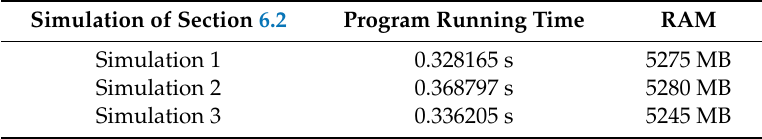
Table 11. Lower model program run time and required